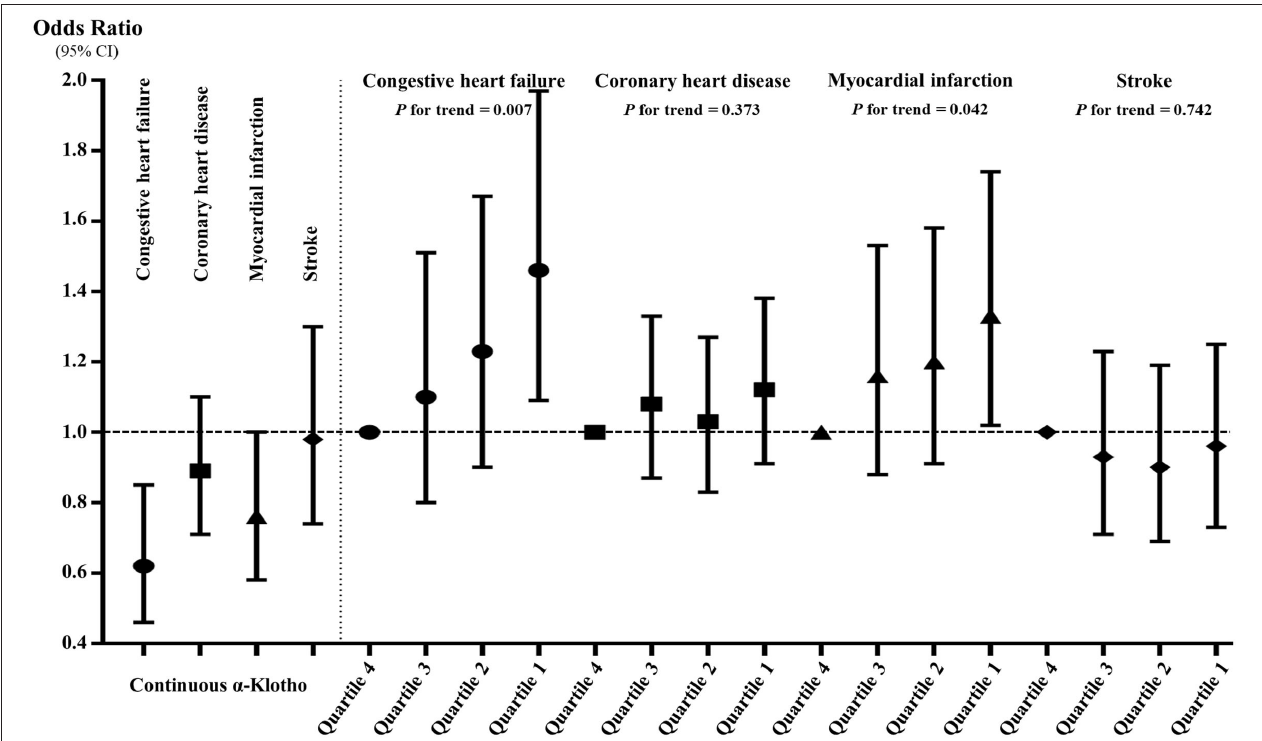
FIGURE 3 | The associations between serum soluble α -Klotho and the four specific cardiovascular diseases in continuous and quartile analyses after full adjustment. The α -Klotho concentrations were the ln-transformed in the continuous analysis.